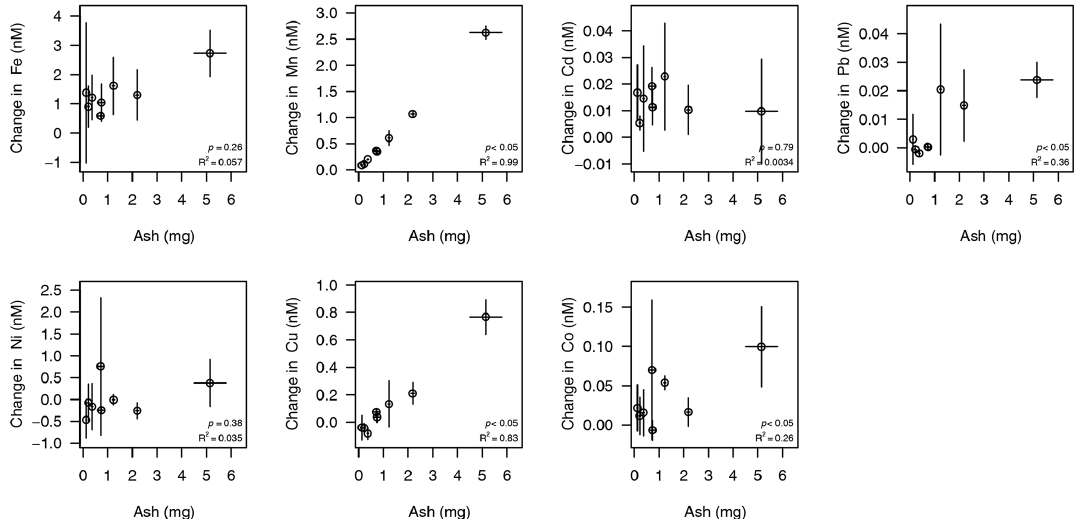
Figure 6. Change in trace metal concentrations after varying ash addition to 100mL of South Atlantic seawater for a 10min leach dura- tion at room temperature. Initial (mean ± standard deviation) dissolved trace metal concentrations – deducted from the final concentra- tions to calculate the change as a result of ash addition – were 0.98 ± 0.03nMFe, 0.38 ± 0.04nMCd, 13 ± 2pMPb, 6.58 ± 0.76nMNi, 0.84 ± 0.07nMCu, 145 ± 9pMCo and 0.72 ± 0.05nMMn. Error bars are standard deviations from triplicate treatments with similar ash loadings. p values and R 2 values for a linear regression are annotated. Source data are provided in the Supplement (Table S5). The same data with individual replicates are also shown in the Supplement (Fig.